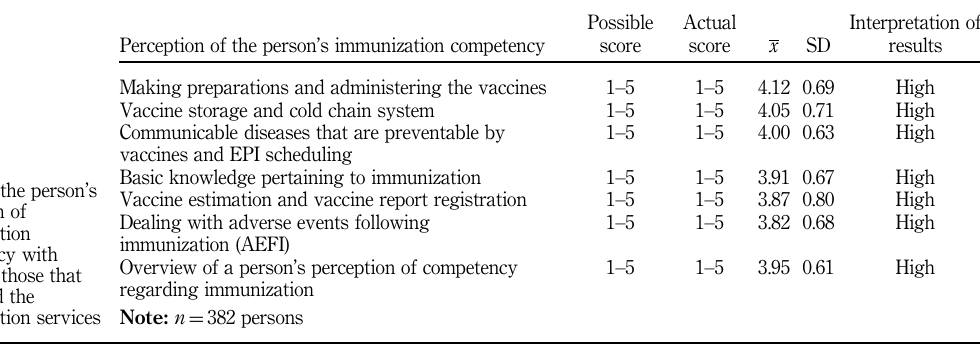
Table I. Scores of the person ’ s perception of immunization competency with regard to those that performed the immunization